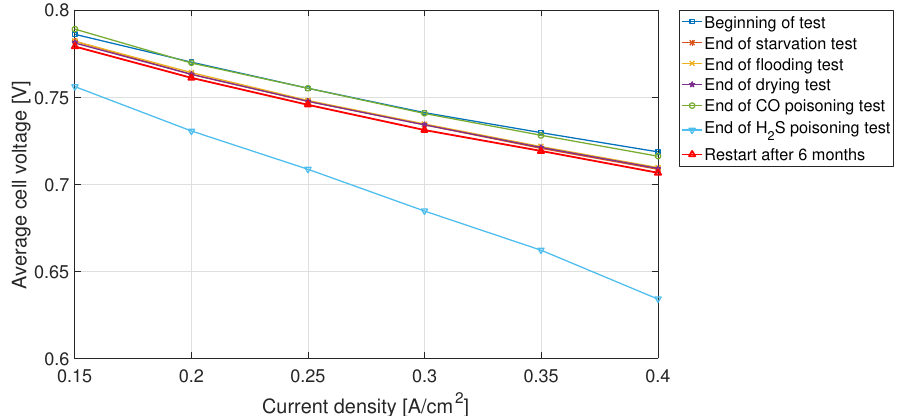
Figure 9. Polarization curves at the beginning of tests, after the end of each fault test, and a final H 2 S recovery test after six months of